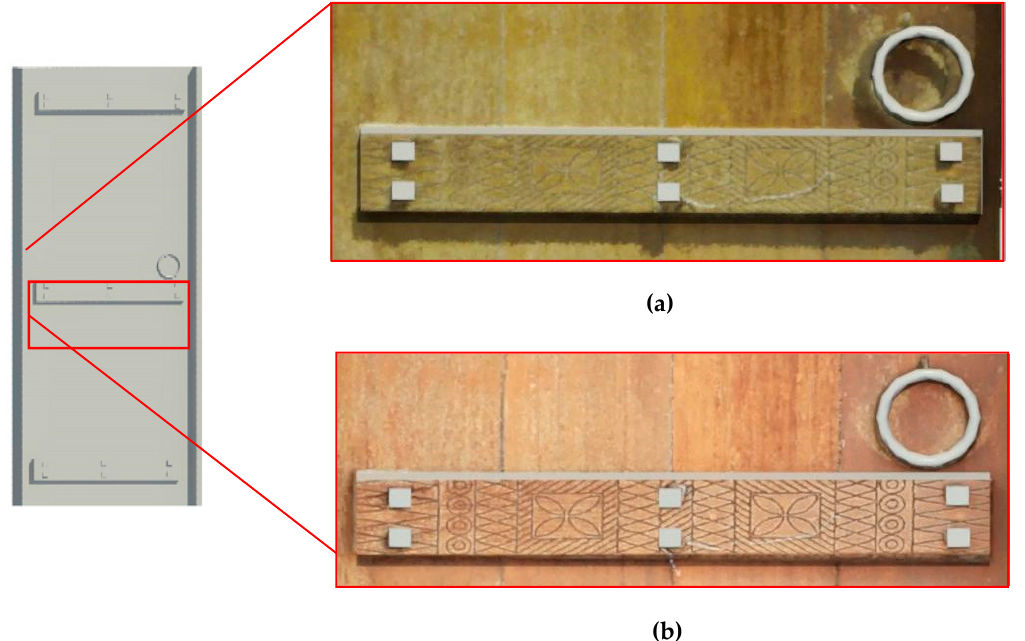
Figure 25. As Textured HBIM using True orthophoto produced by a) TLS camera, b) external Camera Figure 25. As-Textured HBIM using true orthophoto produced by ( a ) TLS camera, ( b ) external